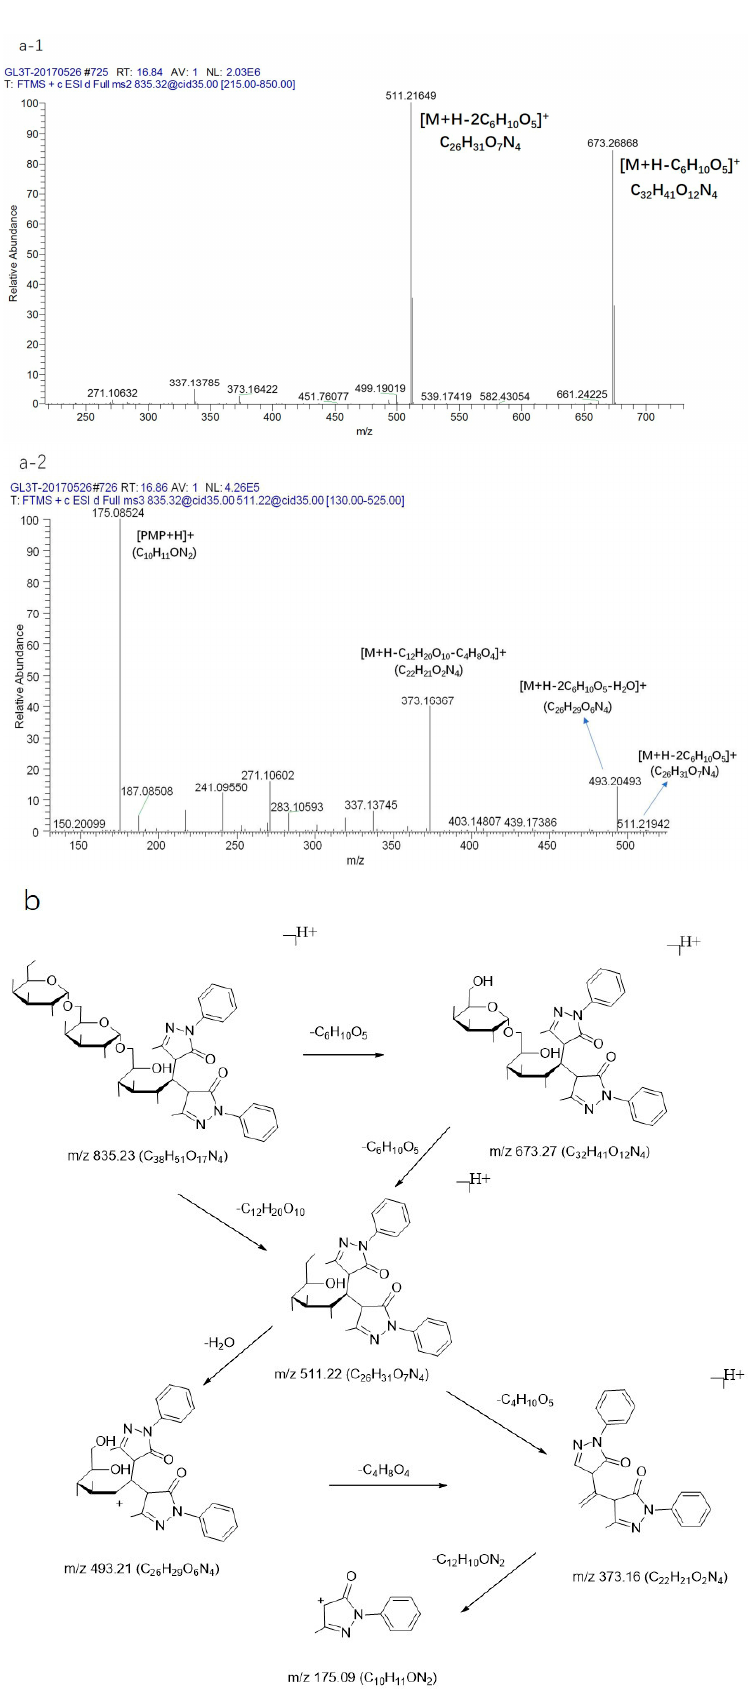
Figure 6. The ( a-1 , a-2 ) CID MS n spectrum and ( b ) fragmentation pathway of the standard of manninotriose.